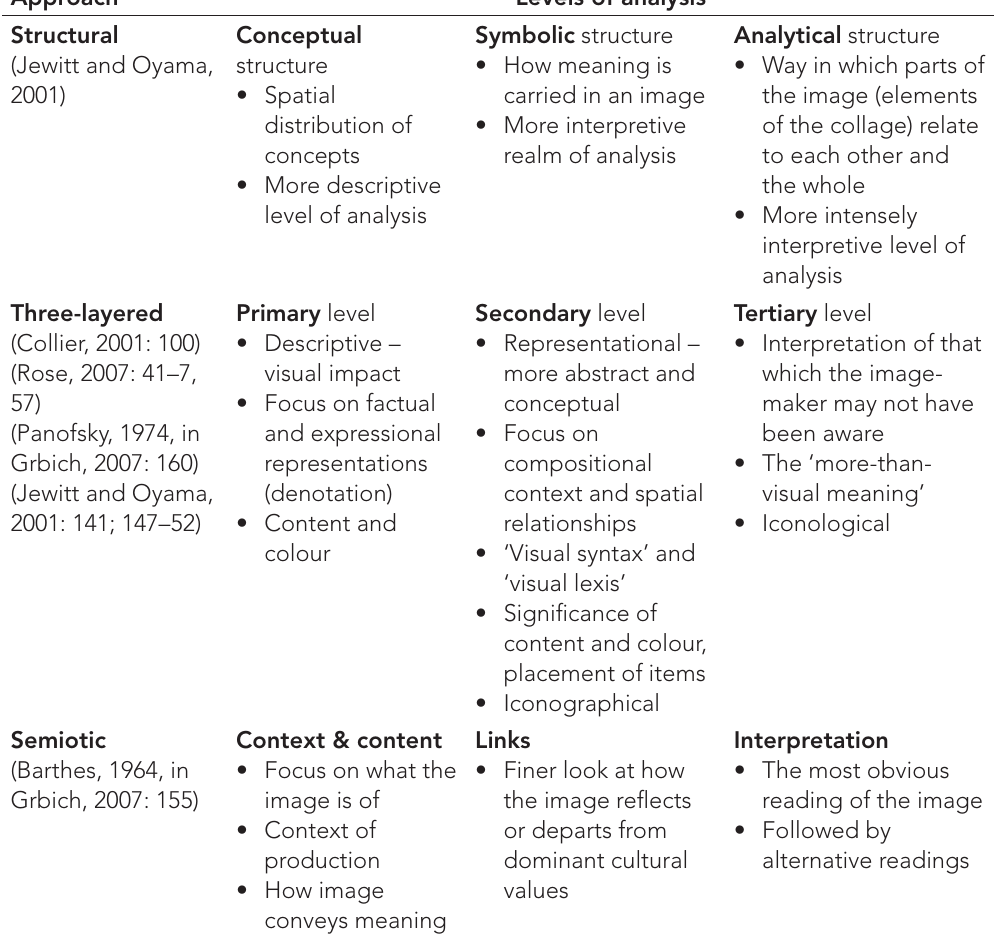
Table 1: Approaches to image analysis Approach